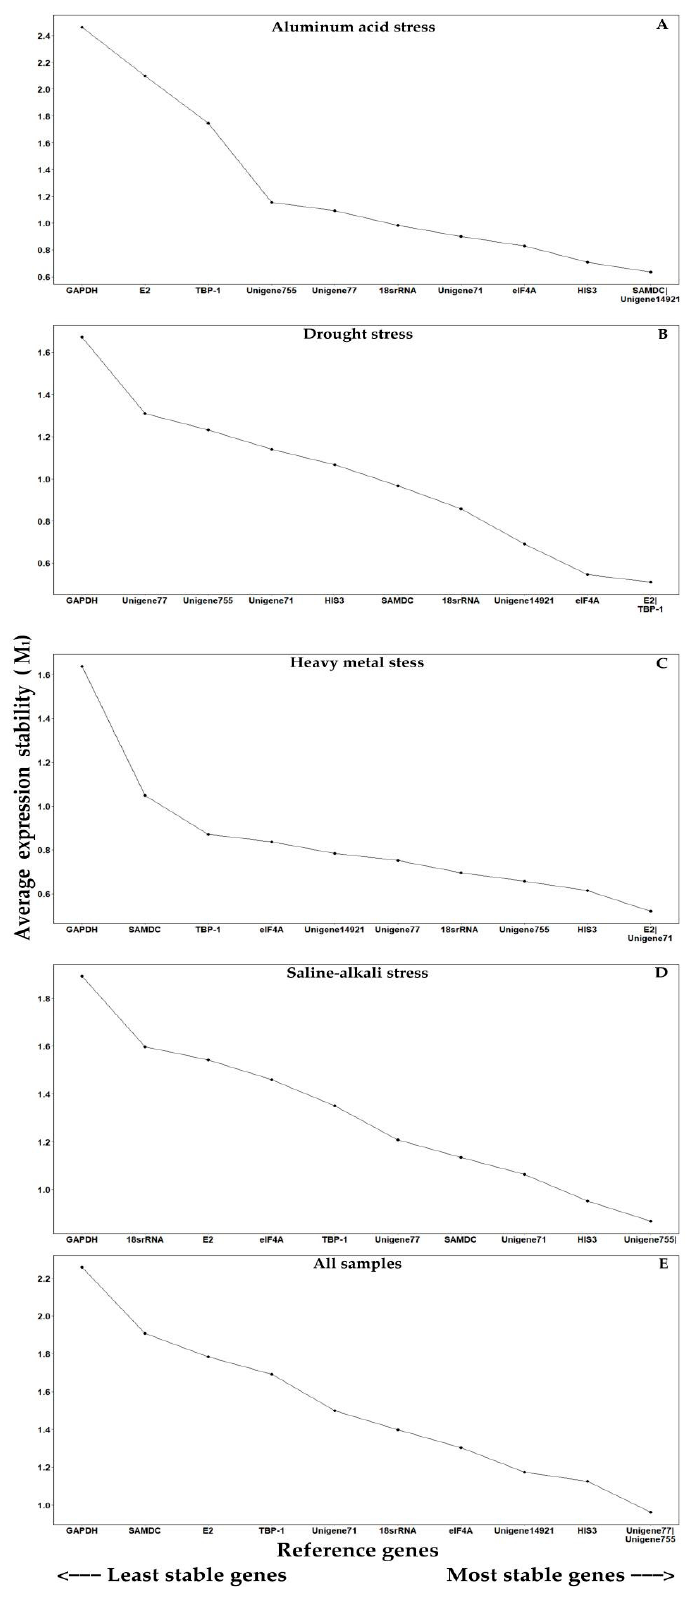
Figure 4. Average expression stability values (M 1 ) of candidate reference genes by GeNorm analysis: ( A ) acidic aluminum stress exposure; ( B ) drought stress exposure; ( C ) heavy metal stress exposure; ( D ) saline-alkali stress exposure; ( E ) all samples.